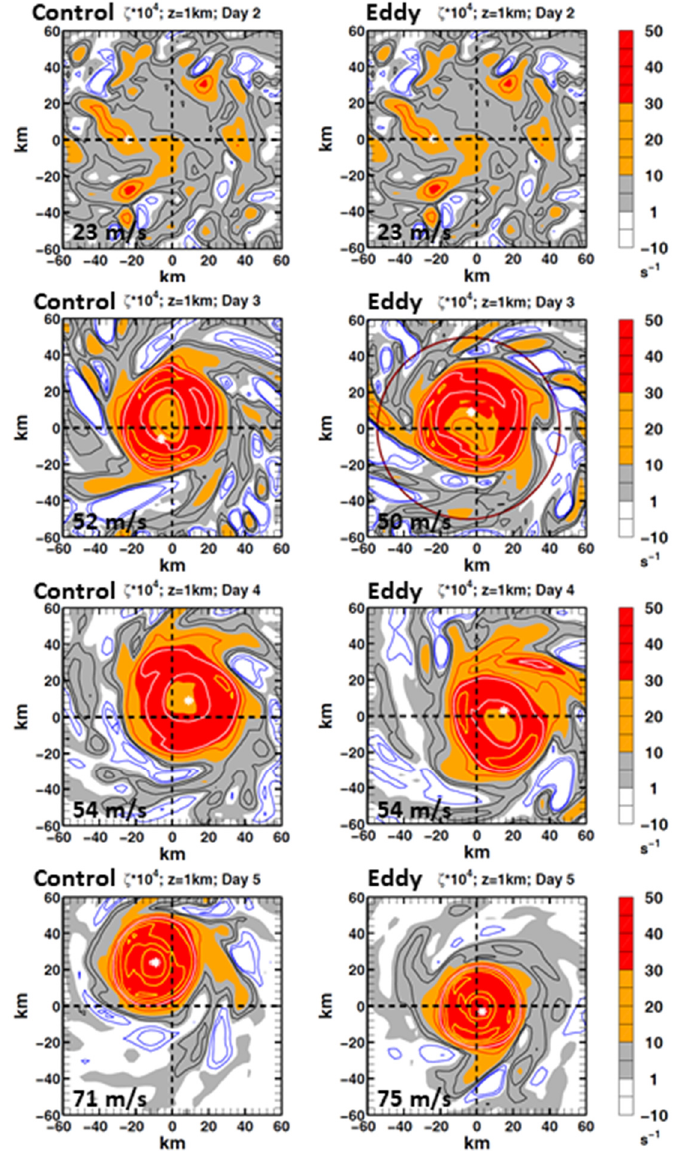
Figure 2. Vertical vorticity ζ × 10 4 (s − 1 ) at z=1 km on days 2, 3, 4, and 5 (from top to bottom rows) for (left) the control and (right) the warm-eddy experiment. Blue contours: ζ = ( − 3, − 1) × 10 − 4 s − 1 , black: ζ = (3, 6) × 10 − 4 s − 1 , red: ζ = 20 × 10 − 4 s − 1 , white: ζ = 40 × 10 − 4 s − 1 , and yellow: ζ = (60, 80, 100, 120) × 10 − 4 s − 1 . White asterisk marks minimum SLP location. Dark-red circle at day 3 (right) is eddy SST = 28.8 °C when the eastward-moving eddy is under the storm. Maximum 10-m wind speeds are shown at lower-left, showing RI from days 2 to 3 and days 4 to 5. Note day 2 is the same for both